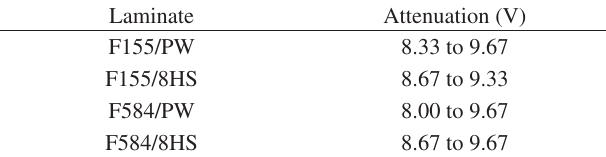
Table 4. Attenuation values by ultrasonic inspection of the laminates after molding.